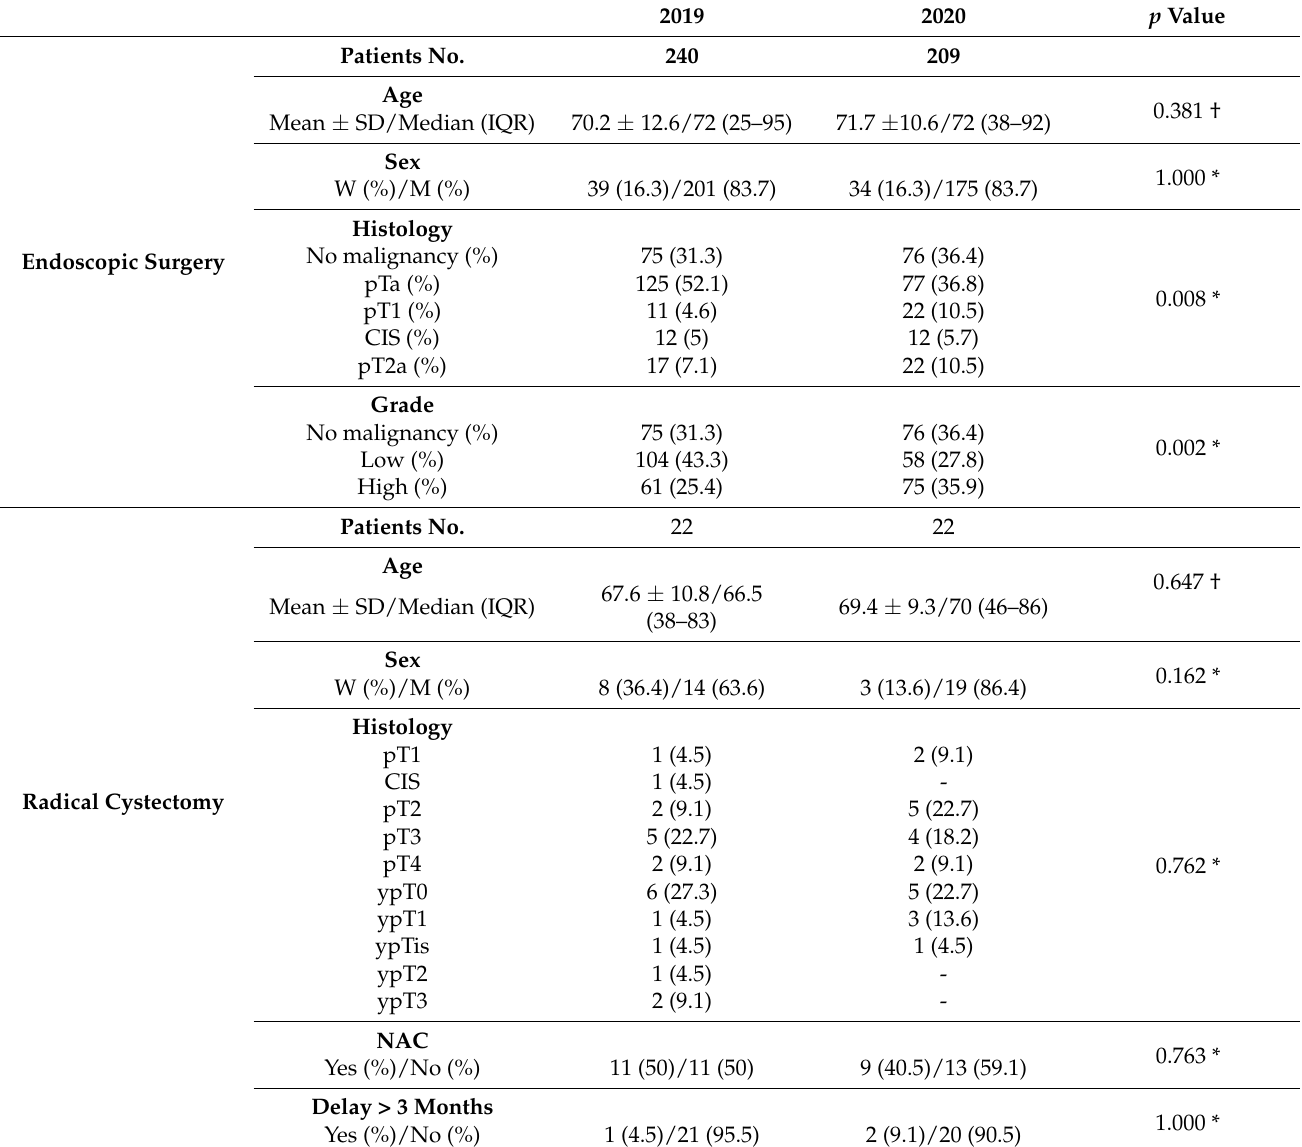
Table 1. Baseline patient